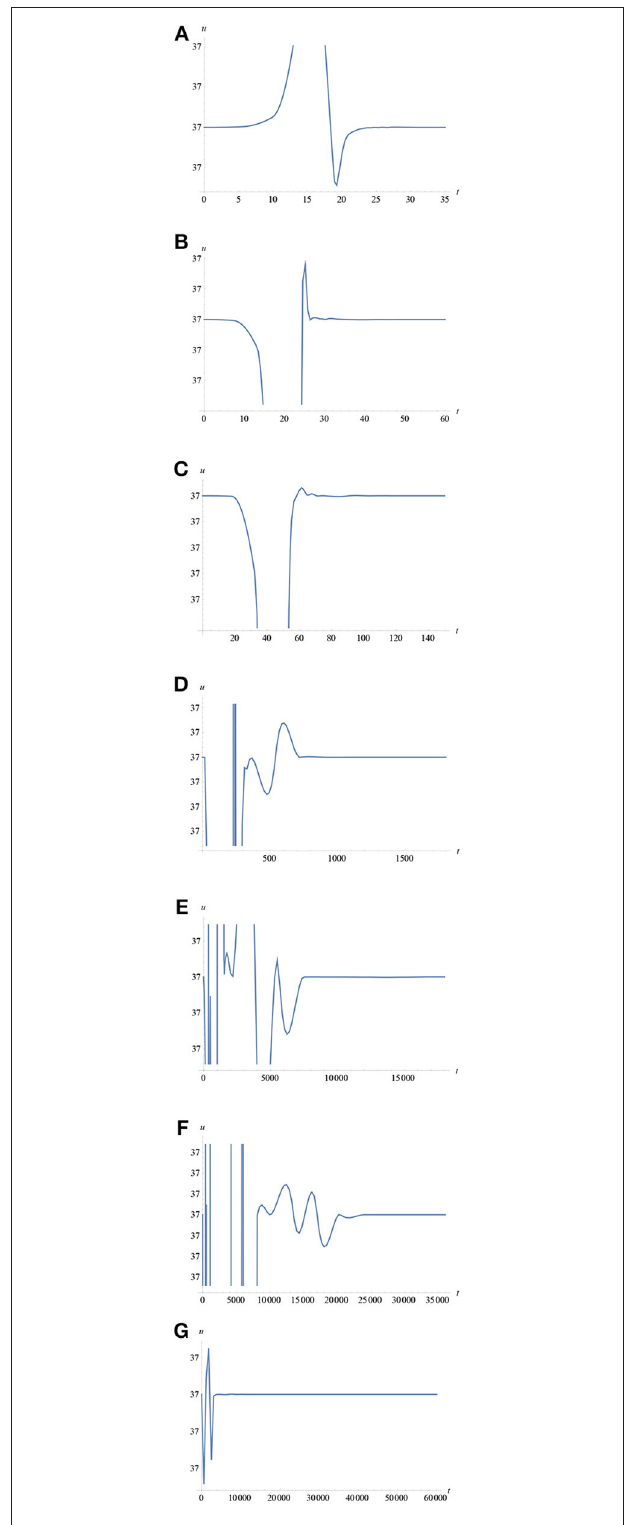
FIGURE 16 | (A) Heat-Solution up to 35s. (B) Heat-Solution up to 60s. (C) Heat-Solution up to 160s. (D) Heat-Solution up to 30min. (E) Heat-Solution up to 5h. (F) Heat-Solution up to 11h. (G) Heat-Solution up to